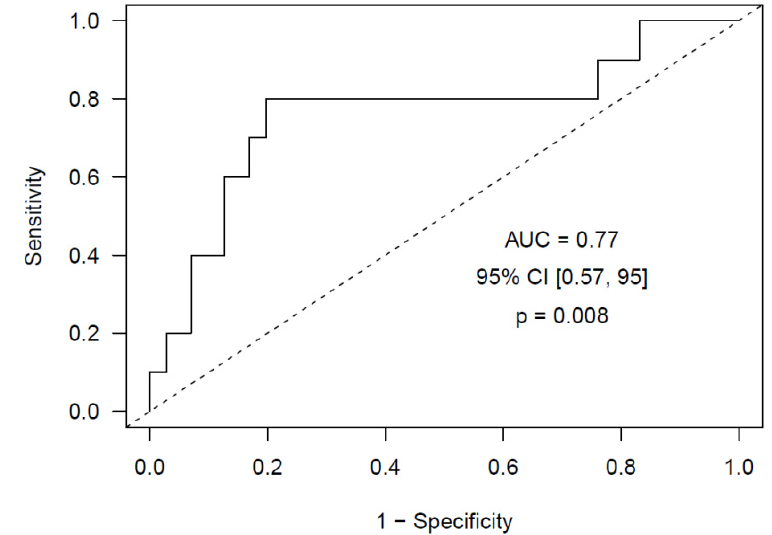
Figure 2. ROC curve obtained using the Elastic Net model that includes calprotectin as risk predictor of future VTE in PDAC and DECC patients at diagnosis.